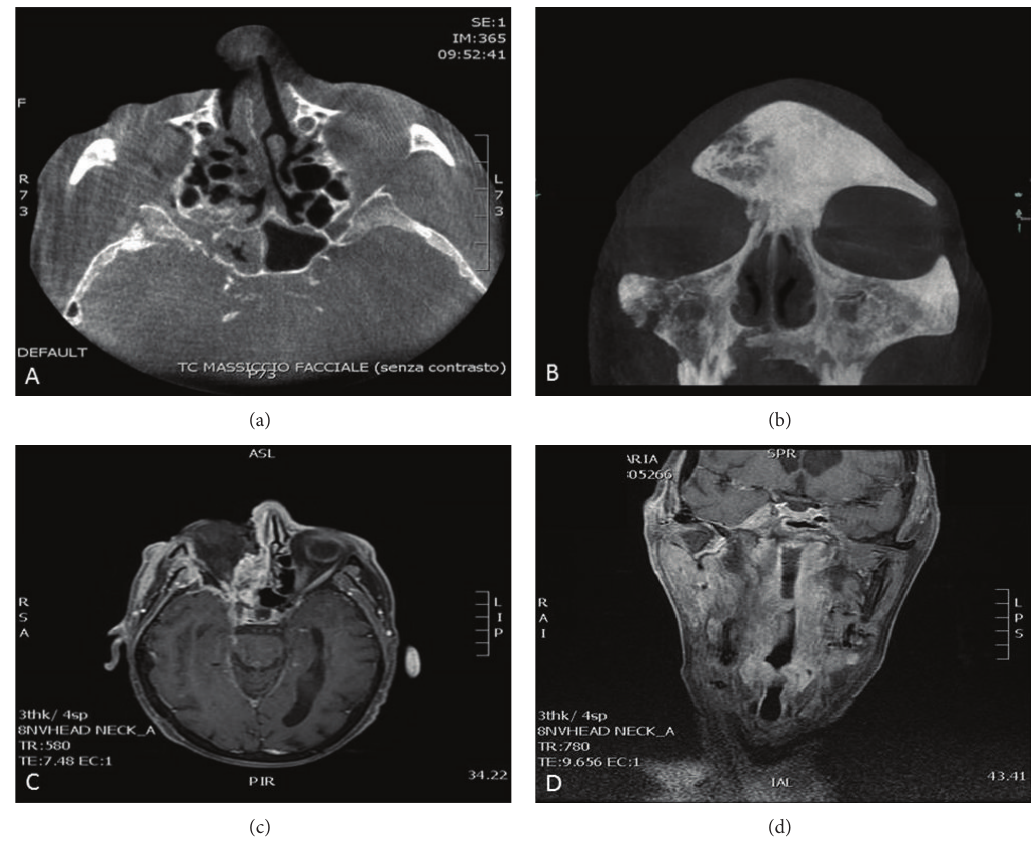
Figure 1: Base (axial plane) CT image shows the presence of a soft tissue density mass in the right sphenoid sinus, occluding the sinus lumen and the spheno-ethmoid osteum also osteostructural alterations, mainly lytic, of the lateral sinus wall and in part of the large sphenoid wing (a); base (coronal plane) CT image with MIP (maximum intensity project) reconstruction shows lytic osteostructural alteration of the right side of the hard palate, with interruption of the cortical contour and, in part, of the alveolar process of the jaw in the first sextant (b); axial T1-weighted MRI image after mdc administration shows meningeal enhancement in the right temporal lobe. Also enhancement of the temporiun on the right side and the Sylvian aqueduct indicating transcompartment fungal infection involvement (c); coronal T1-weighted MRI image after administration of mdc shows a large amount of phlogistic tissue, intensely and homogenously enhanced after mdc, which fills the Meckel’s cavity and engulfs the intracavernous branches of the internal carotid artery in the absence of perceptible ischaemic lesions of the brain parenchyma